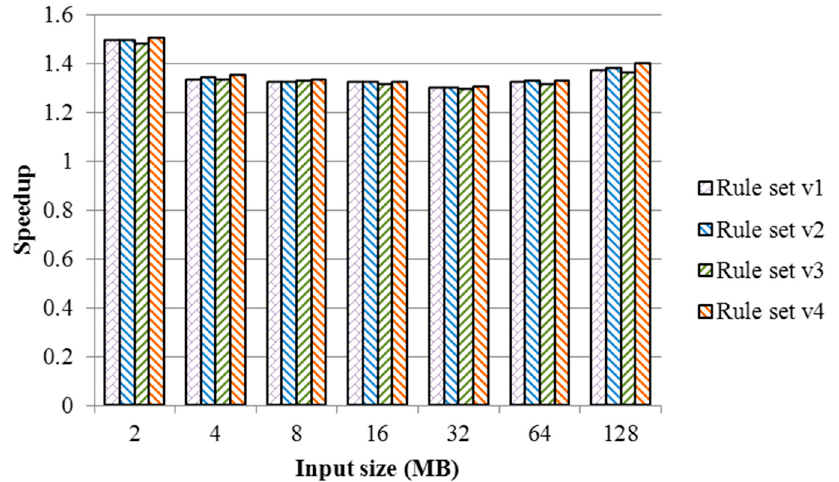
Figure 9. Comparison of speedup between two-phase PFAC and PFAC algorithms with different rule sets and input sizes on K20 workstation.